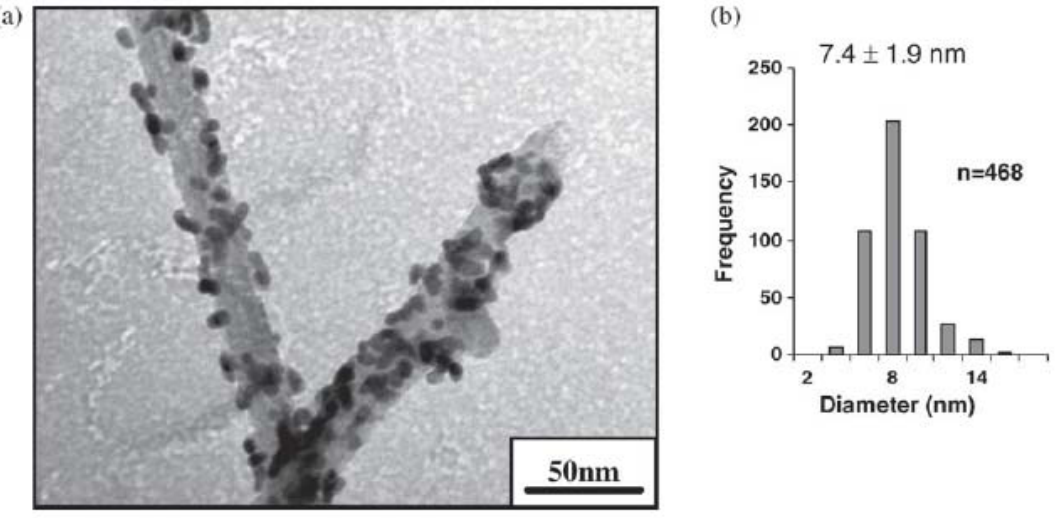
Figure 5. TEM image of the Pd-DMAP nanoparticles bound to MWCNTs (a) Size distribution of the palladium nanoparticles bond to the MWCNTs (b). Reprinted from [44] with permission from Elsevier, ©